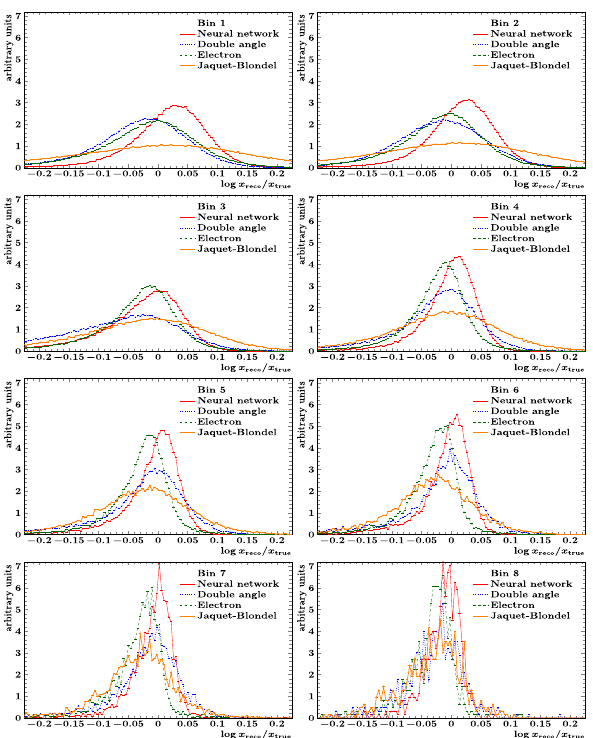
Fig. 6 Distributions of log x − log x true for various reconstruction methods in individual analysis bins. For better visibility, the data points for each reconstruction method are connected with straight lines